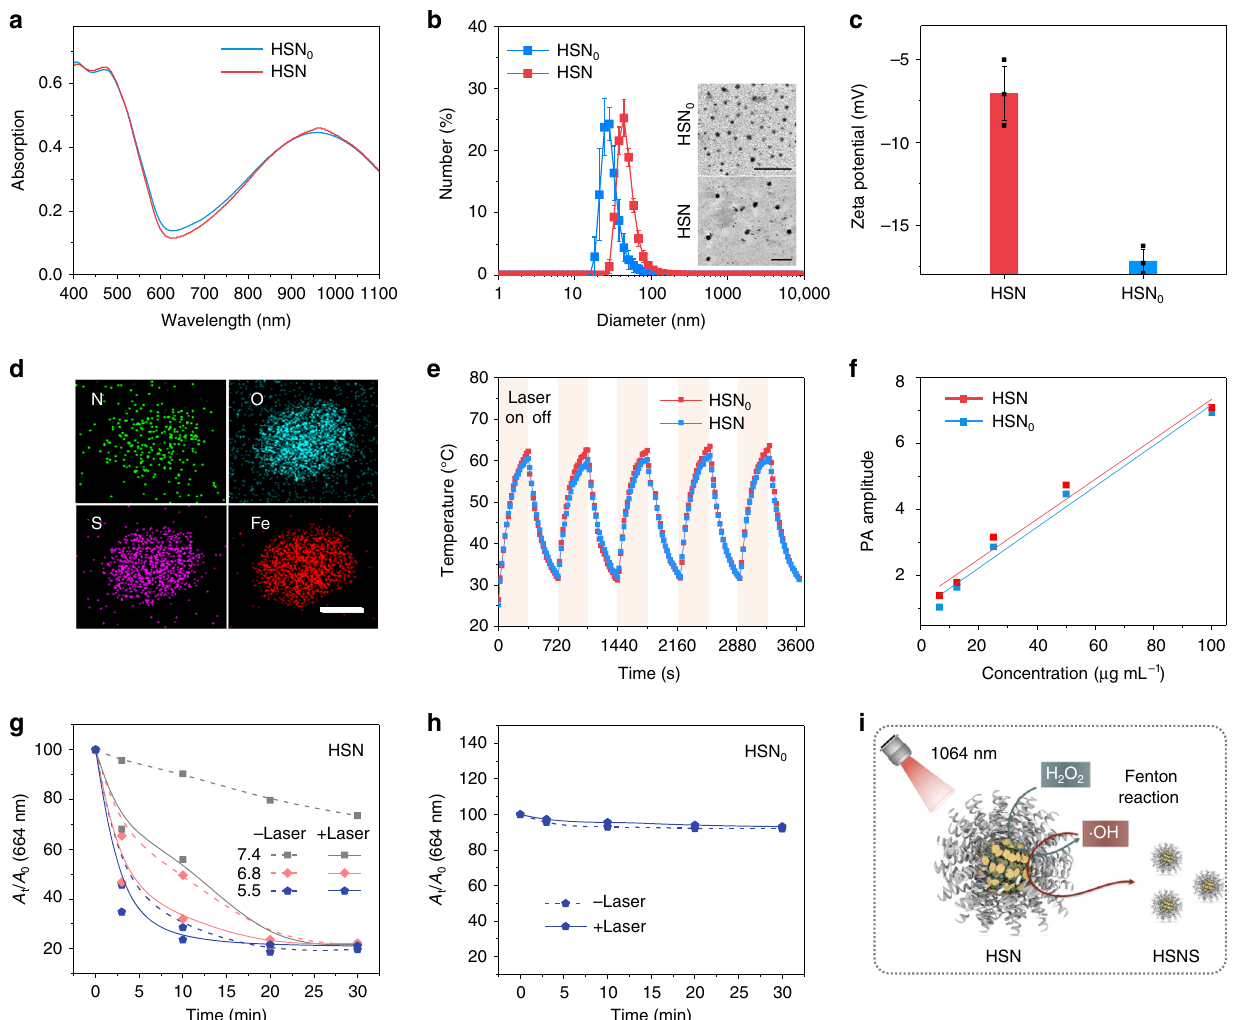
Fig. 2 In vitro characterization of HSN. a Absorption spectra of HSN and HSN 0 in 1 × PBS ([pTBCB] = 3 µ g mL − 1 ). b DLS pro fi les of HSN and HSN 0 in 1 × PBS. Inset : TEM images of HSN 0 and HSN. Scale bar: 200 nm. c Zeta potential pro fi les of HSN and HSN 0 . d STEM-EDX element mapping of HSN. Scale bar: 20 nm. e Photothermal heating-cooling cycles of HSN and HSN 0 ([pTBCB] = 12 µ g mL − 1 ) under 1064 nm photoirradiation (1 W cm − 2 ). f Linear fi ts of PA amplitudes of HSN ( R 2 = 0.96809) and HSN 0 ( R 2 = 0.97314) as a function of concentration at 1064 nm, respectively. g ·OH generation of HSN under different pH conditions (pH = 7.4, 6.8, 5.5) with or without 1064 nm photoirradiation (1 W cm − 2 ). ·OH generation was quanti fi ed by the decrease of absorbance of MB at 664 nm. [pTBCB] = 23 µ g mL − 1 , [H 2 O 2 ] = 0.5 mM, [MB] = 1 mM. h ·OH generation by HSN 0 at pH 6.8 with or without 1064 nm photoirradiation (1 W cm − 2 ). i Scheme of NIR-II photoirradiation enhanced self-degradation of HSN to HSNS in the presence of H 2 O 2 . Error bars indicated standard deviations of three independent